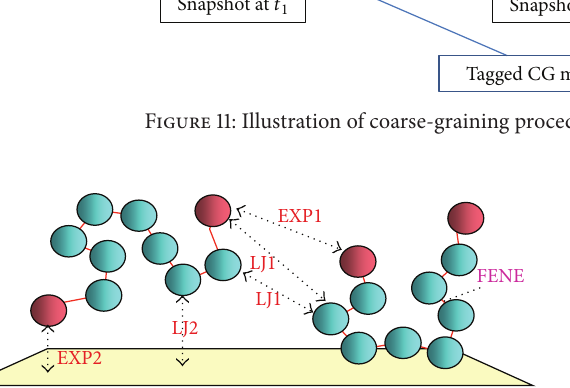
Figure 12: Potential energies for the bead-spring model. LJ1: Lennard-Jones potential, LJ2: van der Waals potential, EXP1 and EXP2: short-range polar potential, FENE: finitely extensible nonlin- ear elastic potential.